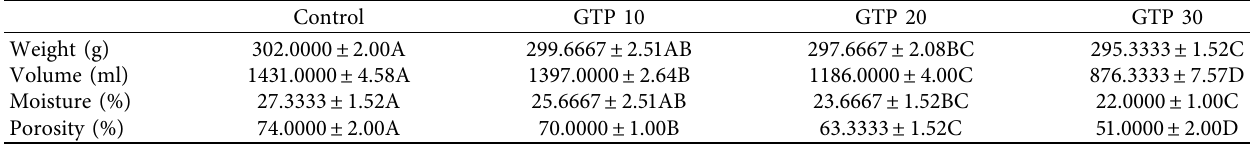
Table 2: Weight, volume, moisture content, and porosity of various sponge cake samples.